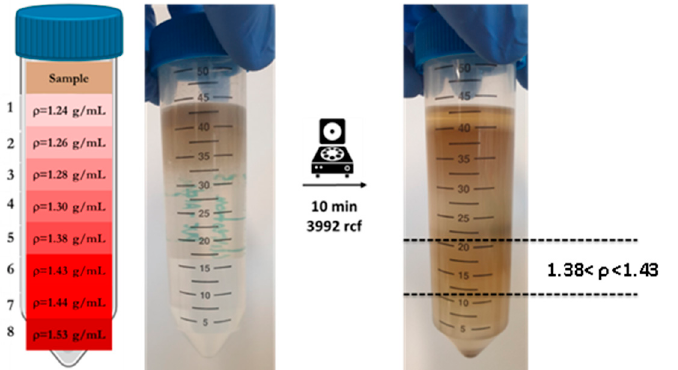
Figure 5. Separation, according to density, of the sample digested through a sucrose-ZnCl 2 gradient by centrifugation.